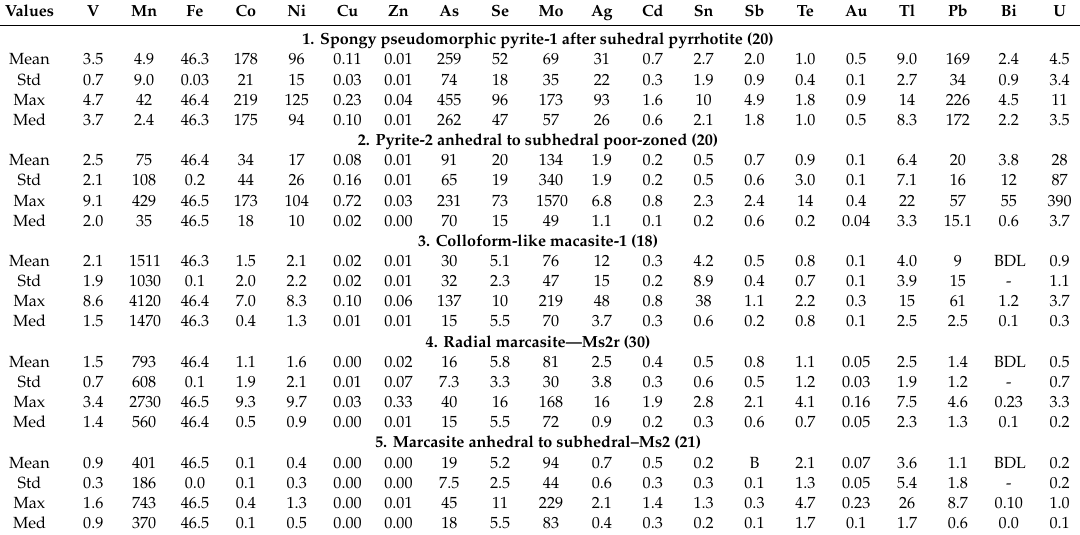
Table 5. Trace element contents in pyrite varieties of marcasite-pyrite microfacies. Pobeda-2 hydrothermal field. LA-ICP-MS data in ppm, Fe, Cu, and Zn in wt.%.